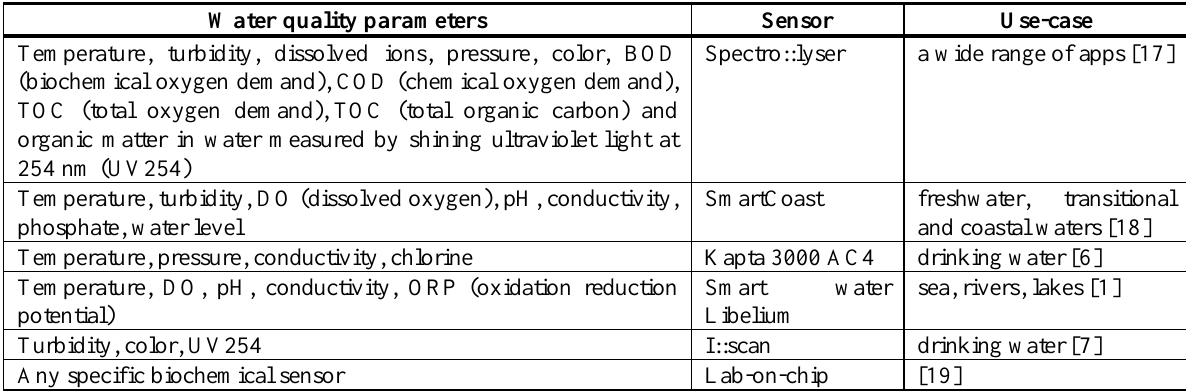
Table 1. Commercially available multi-parameter water sensors (Adapted from [16]) Water quality parameters Sensor Use-case Temperature, turbidity, dissolved ions, pressure, color, BOD Spectro::lyser a wide range of apps